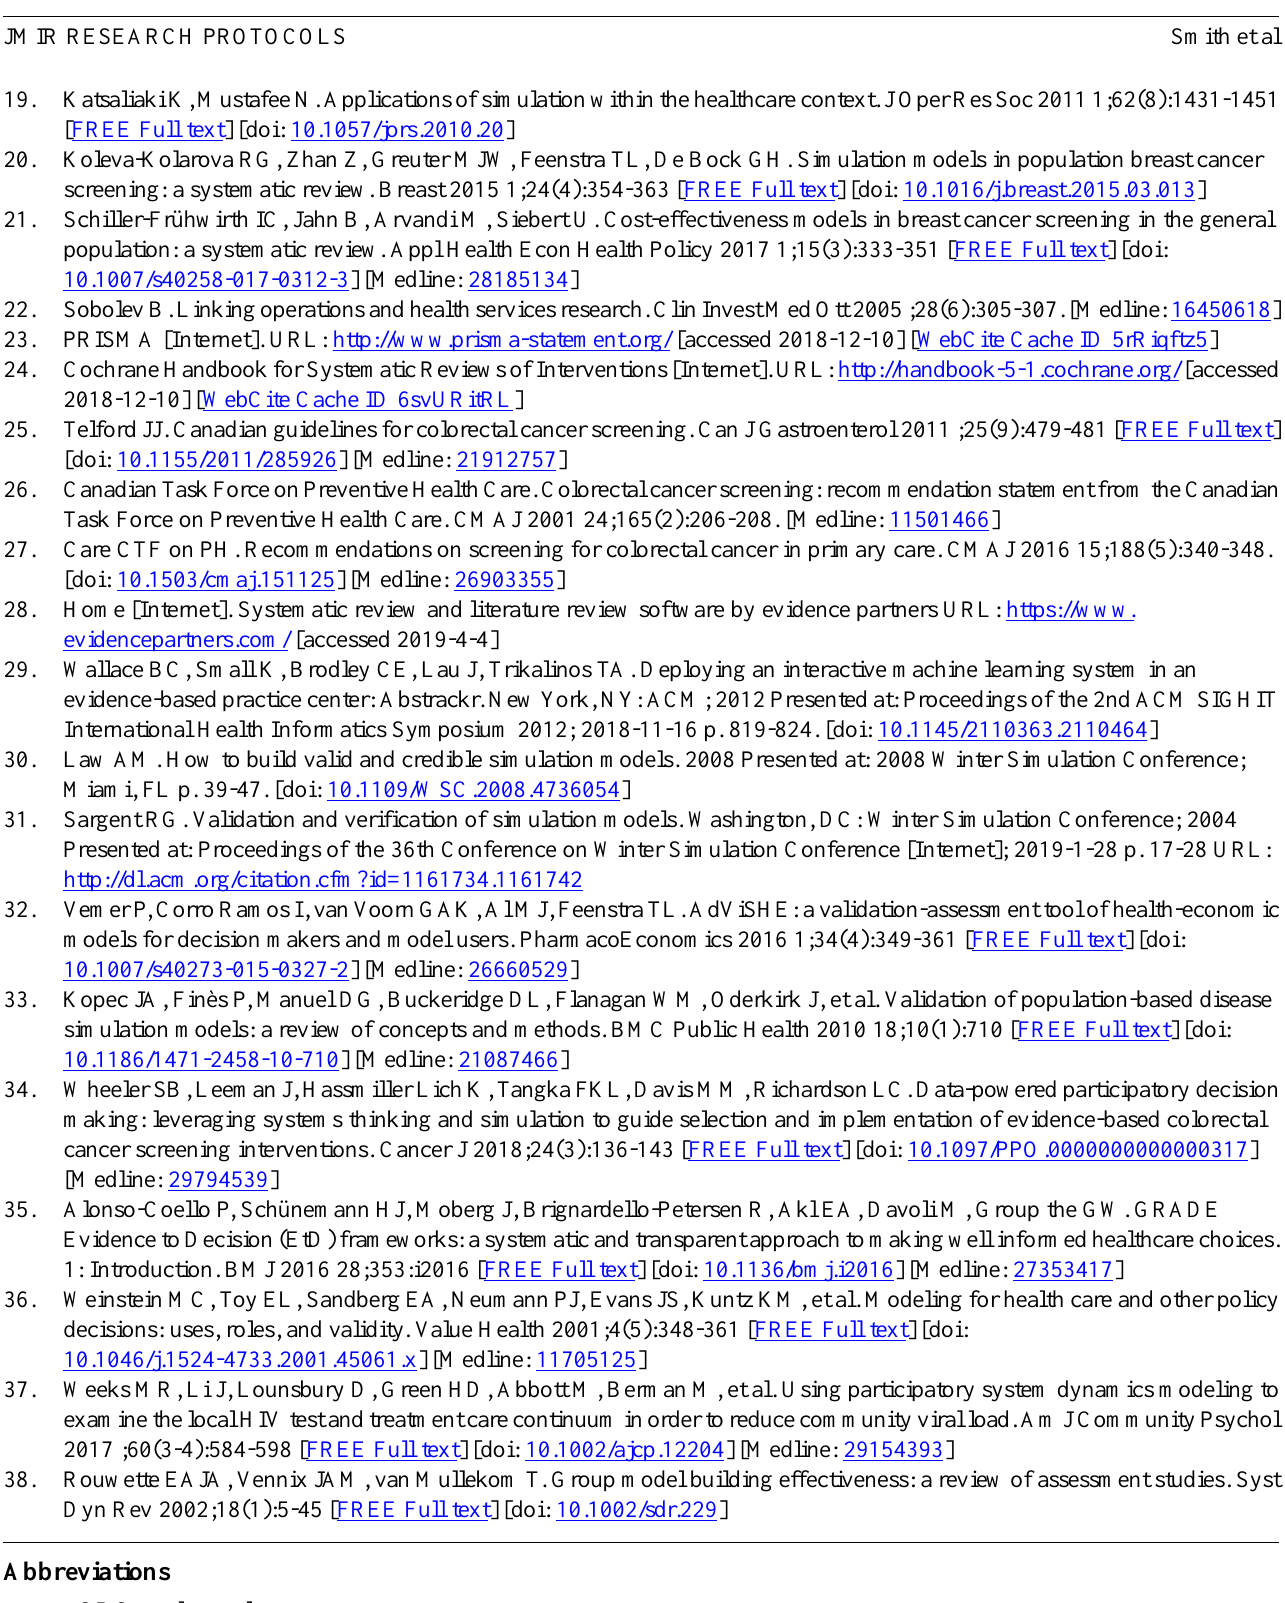
Abbreviations CRC: colorectal cancer GRADE EtD: Grading of Recommendations Assessment, Development and Evaluation Evidence to Decision ISPOR-SMDM: International Society for Pharmacoeconomics and Outcomes Research-Society for Medical Decision